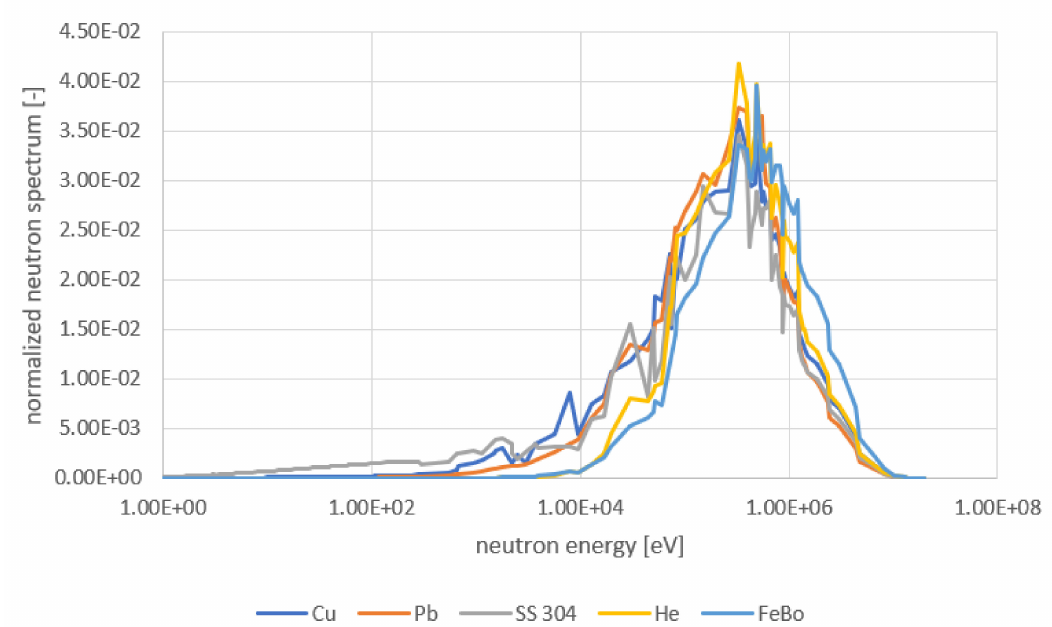
Figure 13. Selected fast reactor neutron spectra in the integrated 2D system, depending on a selection of potential reflector